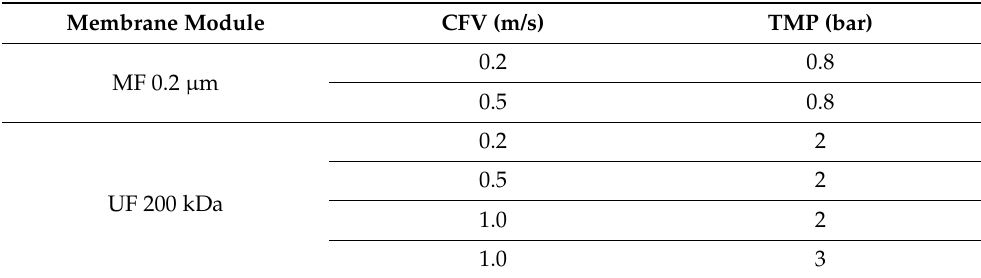
Table 2. Pre-conditions of the membrane